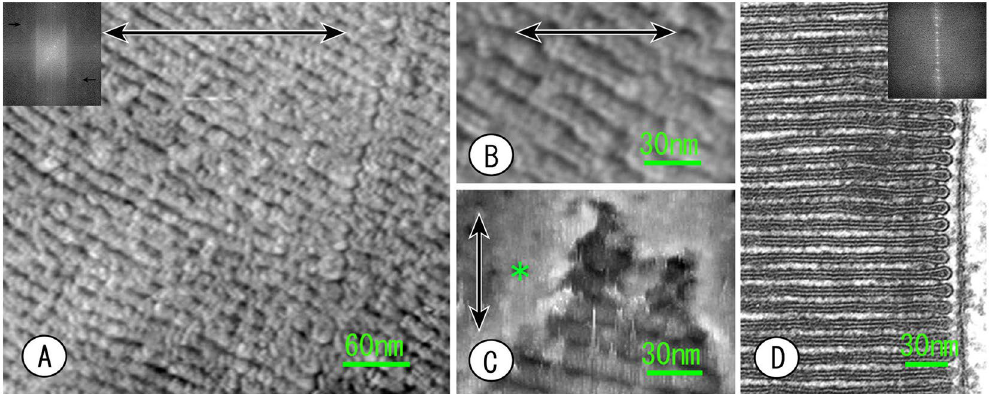
Figure 2. AFM images of the cryosections of photoreceptor rod outer segments after removing the sucrose embedding medium ( A , B , C ). Double-headed arrows indicate the scanning direction of the cantilever. ( A ) Highly ordered piling disks were observed, but the luminal spaces of the disks were almost collapsed, except at the incisures and the peripheral region (compared to the thin section EM image, D ). ( B ) When enlarging the images of part of the disks, the luminal spaces look like slits. The unit membrane structure of the disks that appeared in D was not observed, but the structure appears to contain globular substances. ( C ) The marginal surfaces of the disk membranes are exposed but partially covered with cell membrane (asterisk) when the sections were near the peripheral region. ( D ) Thin-section EM image of the ROS inserted for a comparative analysis and better understanding of the ROS structure. The insets in A and D are Fourier transforms of A and B, respectively. The inset in A shows periodicity of disks piling up, but a high-resolution zone was obscured by another random structure, and there seems to be subtle information in the lateral direction of the disk membranes (arrows). Although the inset in D shows highly ordered periodicity of disks due to the contrast enhanced by the staining effect as though it were a line drawing, there is no information in the lateral direction of the disks.